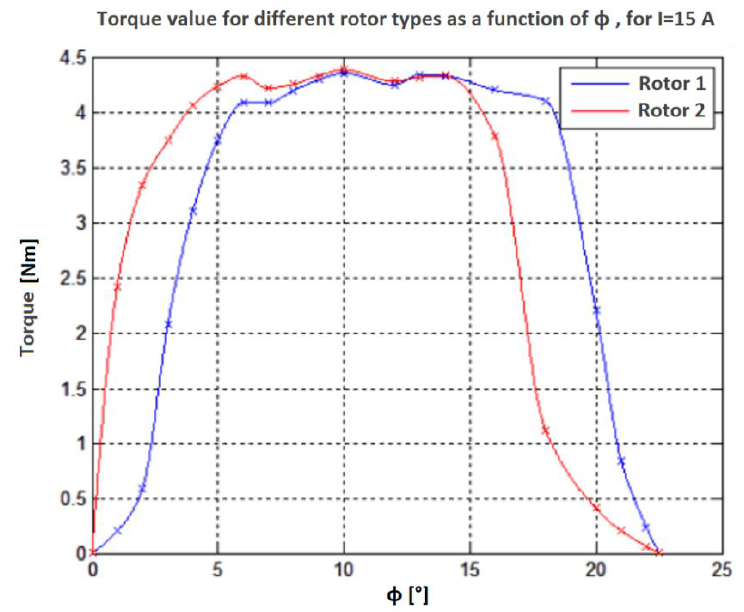
Figure 22. Comparison of torque characteristics obtained for two different rotors.